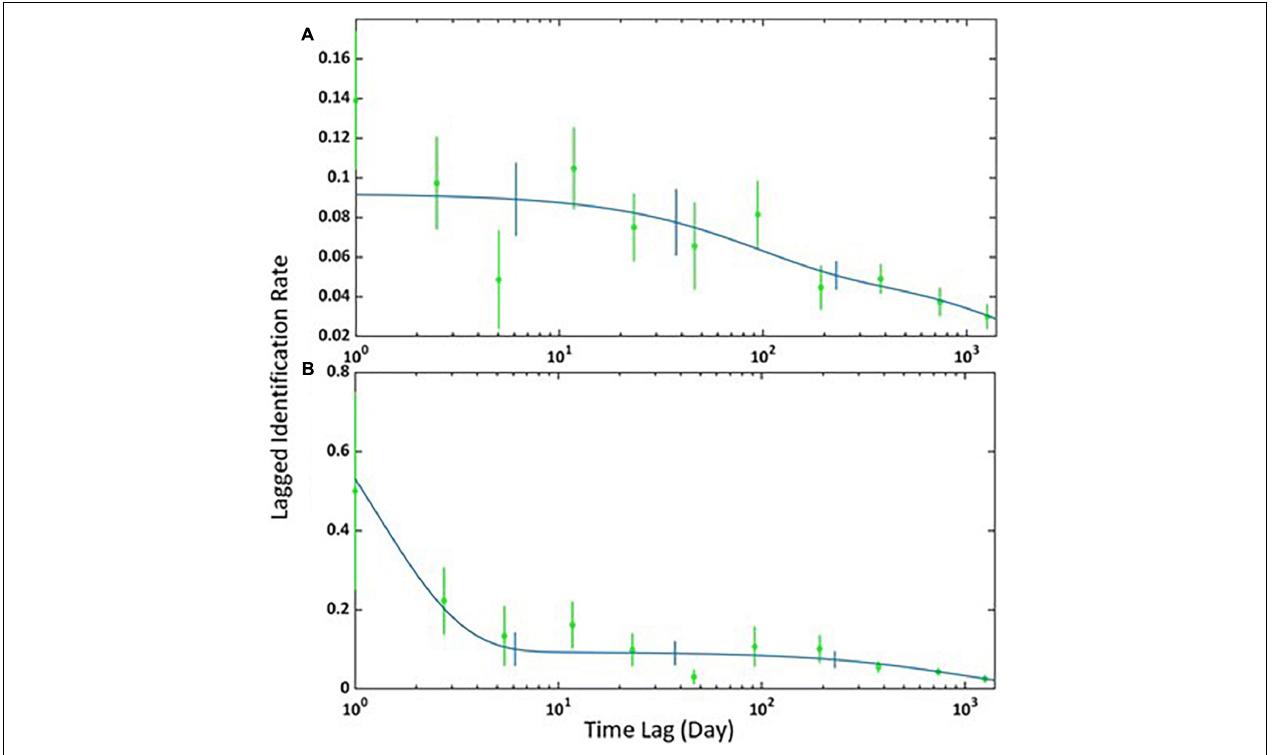
FIGURE 2 | Lagged Identification Rates (LIR) for (A) adult females and immatures and (B) adult and subadult males in Madeira between 2015 and 2019. The graph shows the probability that an individual Blainville’s beaked whale captured at an initial time “0” will be captured again at x time later in the study area. Blue lines represent the best-fitting model according to Table 3 , green circles represent the data, and vertical bars indicate SE calculated using a bootstrap method on each sampling